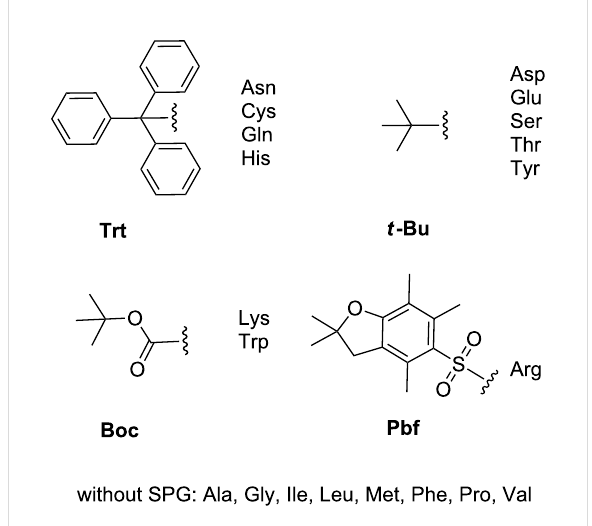
Figure 2: Commonly applied amino acid side chain protecting groups (SPG) in Fmoc/ t -Bu-strategy. Trt: trityl, Pbf: pentamethyl-2,3-dihy-